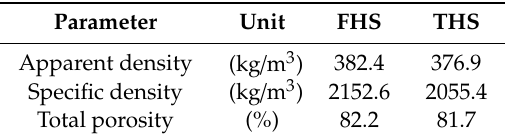
Table 3. Averaged values of apparent density, specific density and porosity of samples of hemp–lime composite with the FHS and